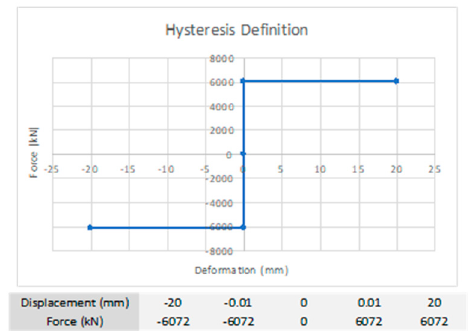
Figure 6. Hysteresis definition for Level 13 SHJ links.